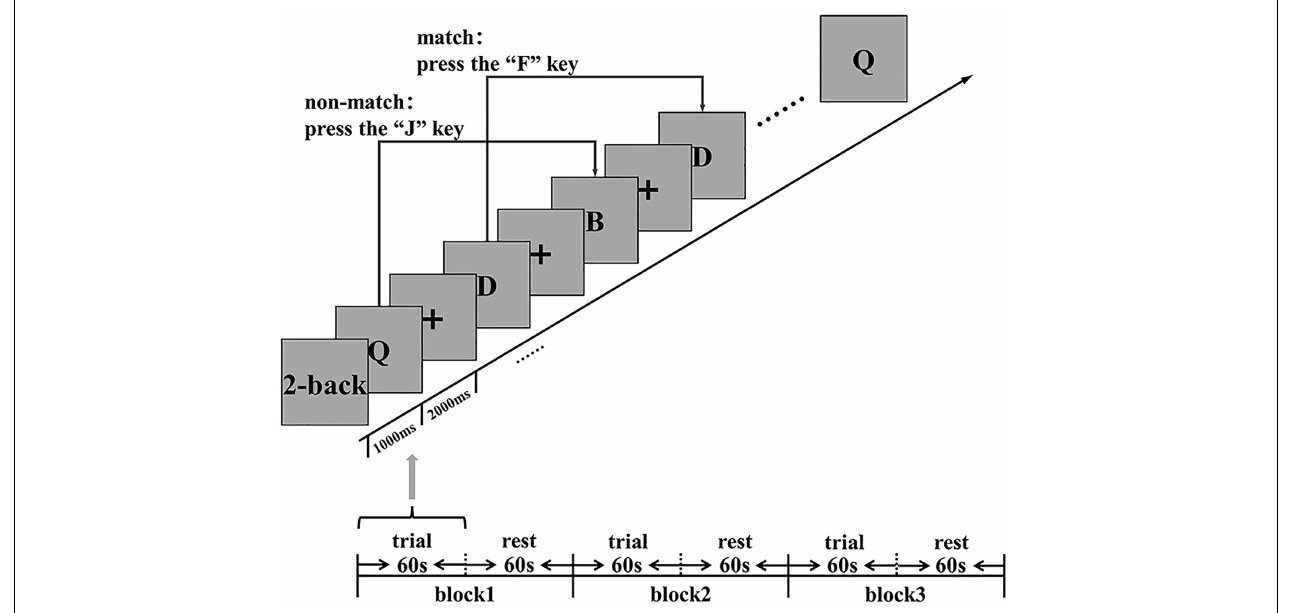
FIGURE 2 | Cognitive function (working memory) assessment: 2-back stimulus display. ms, millisecond; s,